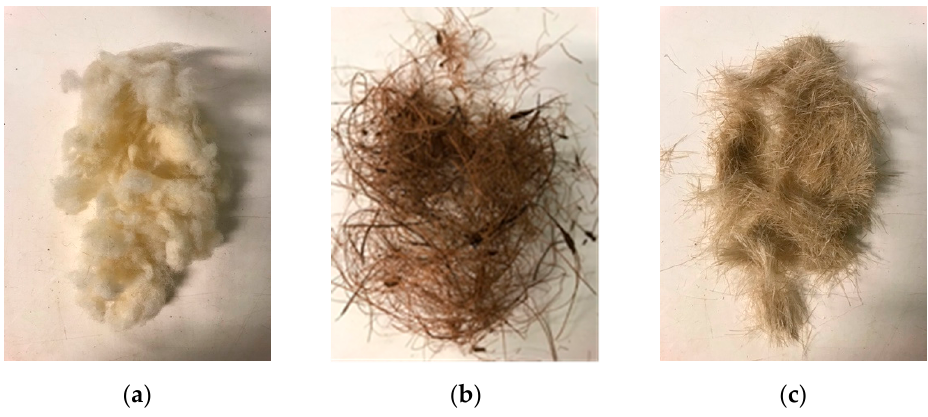
Figure 1. Natural fibres used: ( a ) wool fibres, ( b ) coir fibres and ( c ) flax fibres.